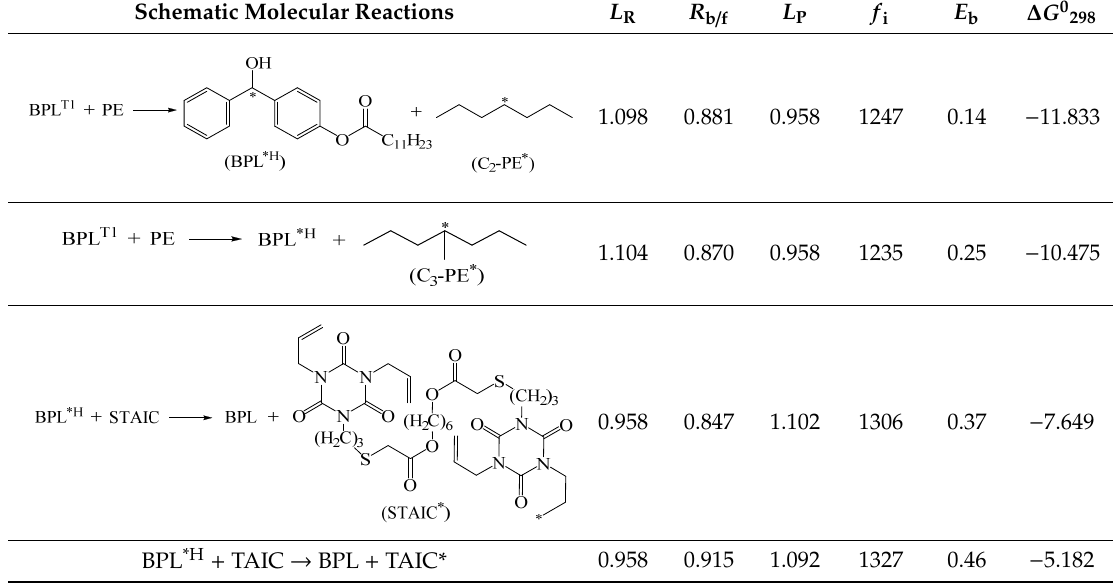
Table 3. Reactant C – H (or O – H) bond length L R (Å) and product O – H (or C – H) bond length L P (Å), hydrogen bond broken/forming length ratio R b/f and imaginary frequency f i (cm − 1 ) of the transition